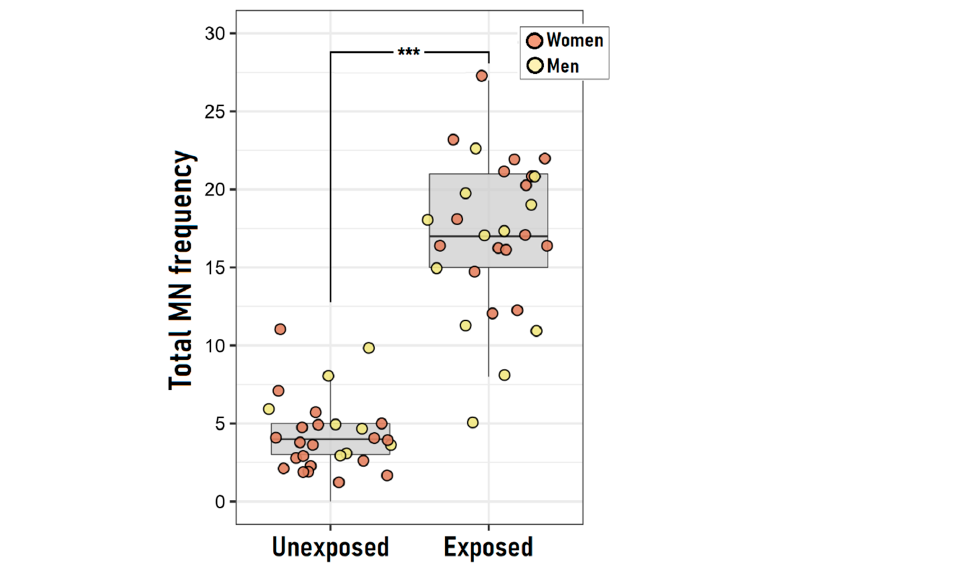
Figure 2. Cytogenetic damage among unexposed and exposed individuals from Curicó (Chile). The boxes and bars represent the interquartile distribution of the individual frequency of binucleated cells with micronuclei (BNMN). The central line inside the boxes represents the data median. Comparison of cytogenetic damage level between study groups was performed through a U -Mann Whitney test. *** = p < 0.001. Table 2. Cytogenetic damage levels and frequency of reproductive problems between groups.